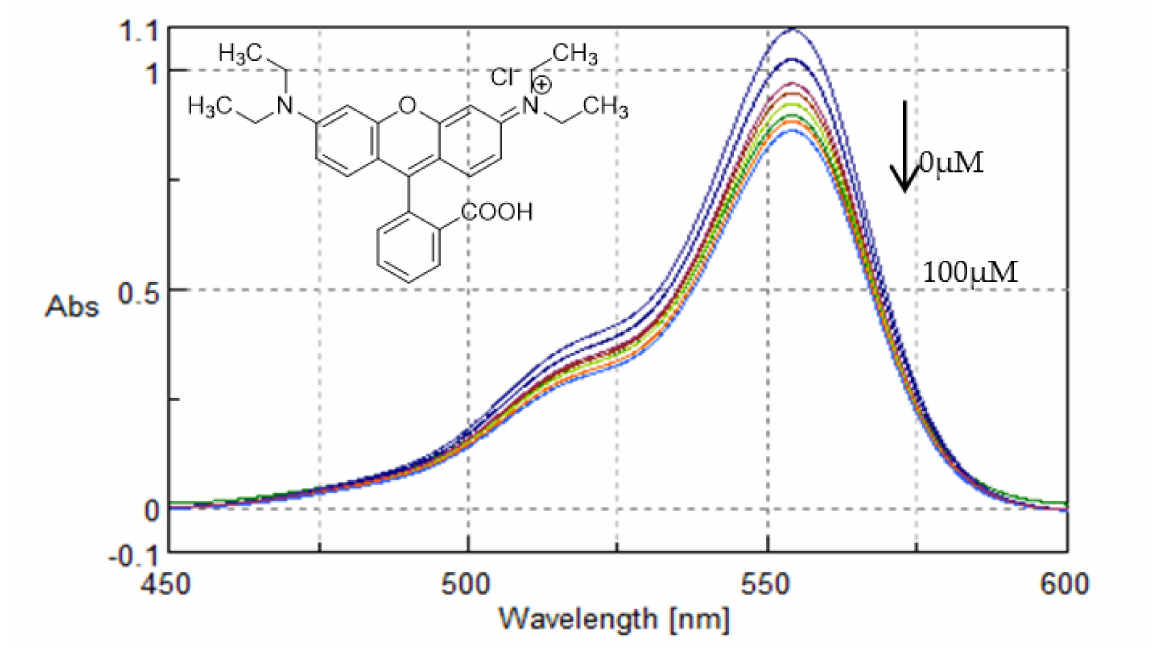
Figure 15. UV-Vis spectra of Rhodamine B with increasing concentrations of ctDNA (0–100 µ M). Arrow refers to hypochromic effect.